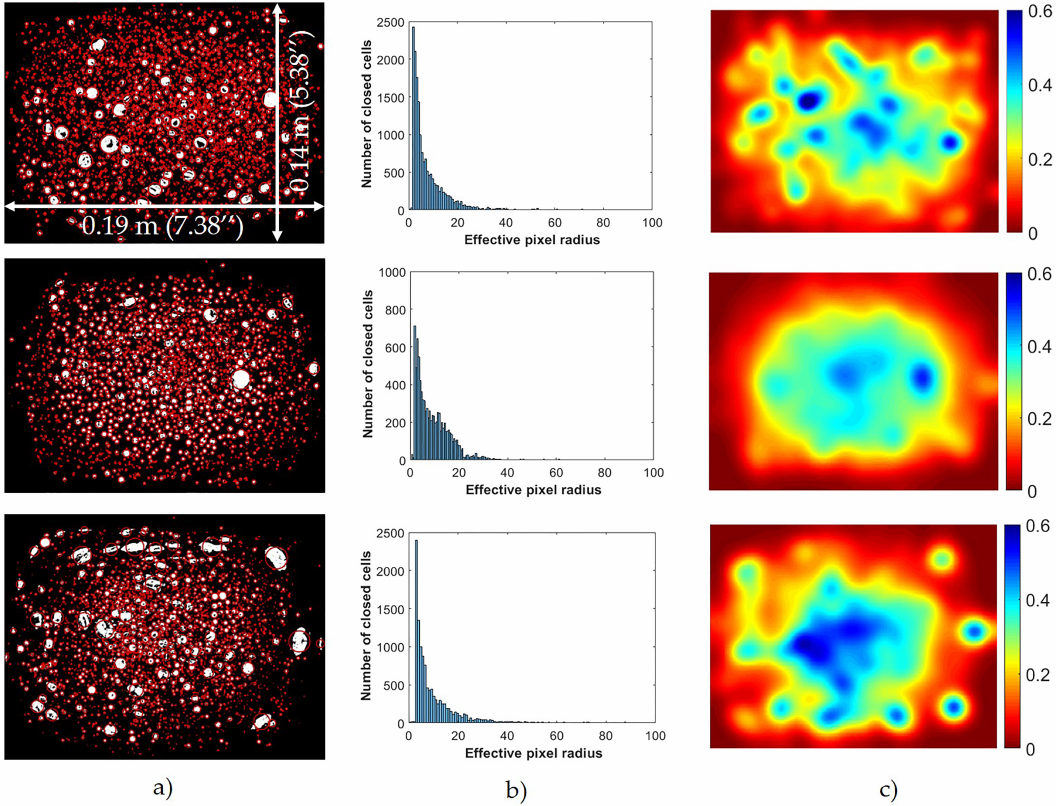
Figure 7. Various stages within the MATLAB image processing technique. ( a ) Cell area identification for samples 1 through 3. ( b ) Histograms of the cell size distribution for samples 1 through 3. ( c ) Spatially varying effective local density for samples 1 through 3 within the foamed